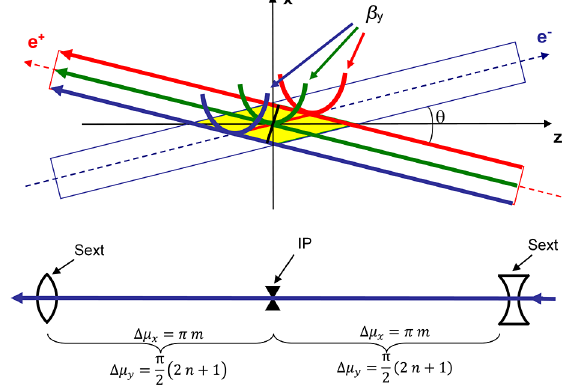
FIG. 2. Crab waist collision